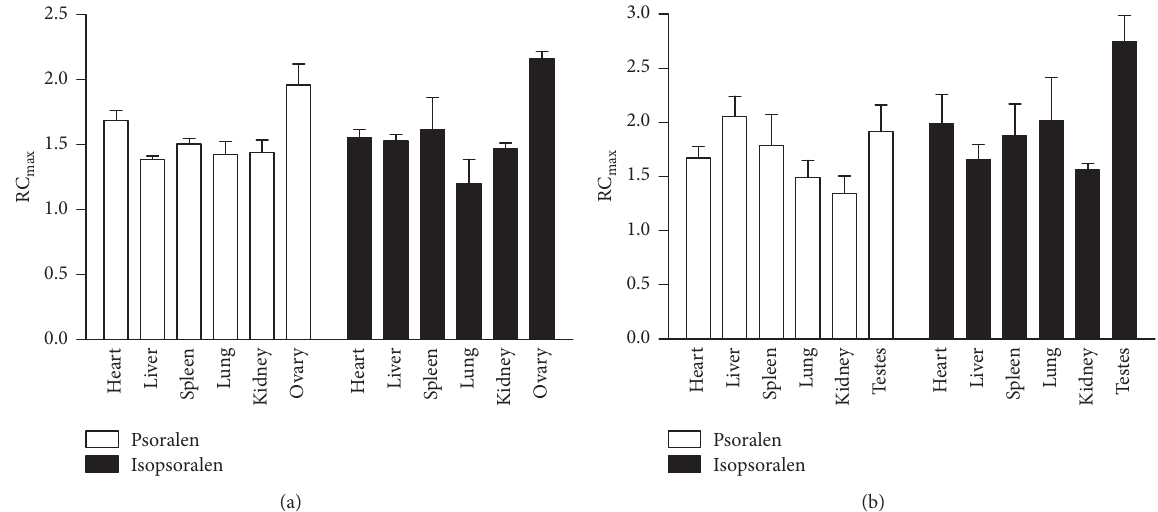
Figure 5: RC profiles of psoralen and isopsoralen in male and female rat tissues. (a) Psoralen and isopsoralen in female rat; (b) psoralen max and isopsoralen in male